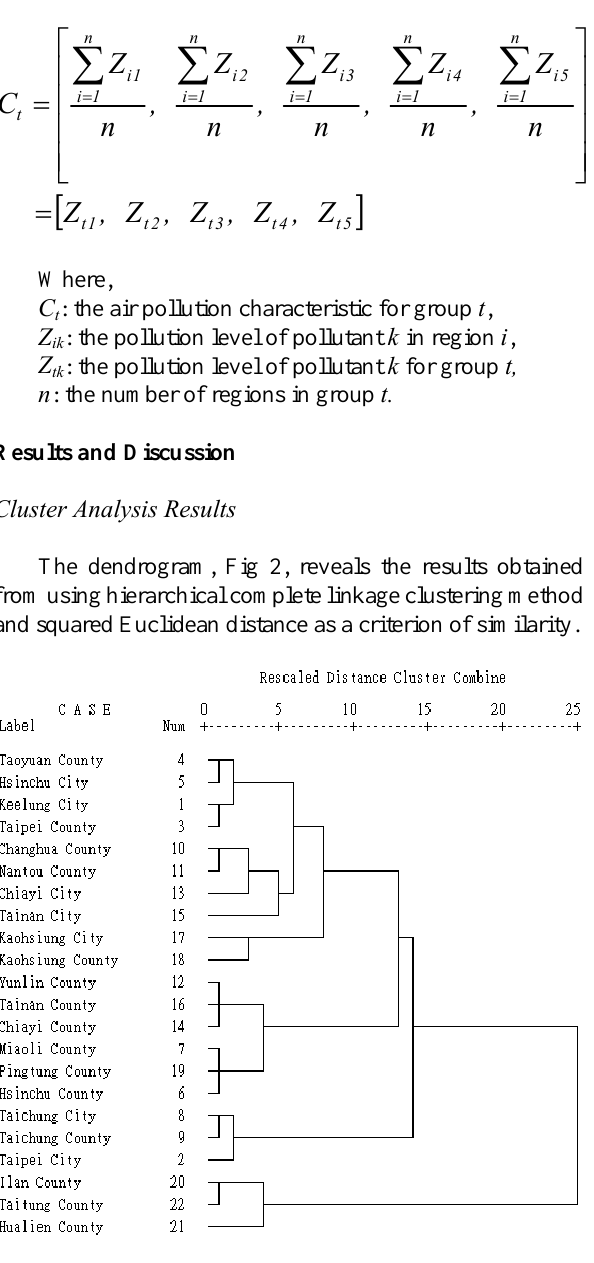
Figure 2: Dendrogram of the CA based on regional air pollution characteristic.